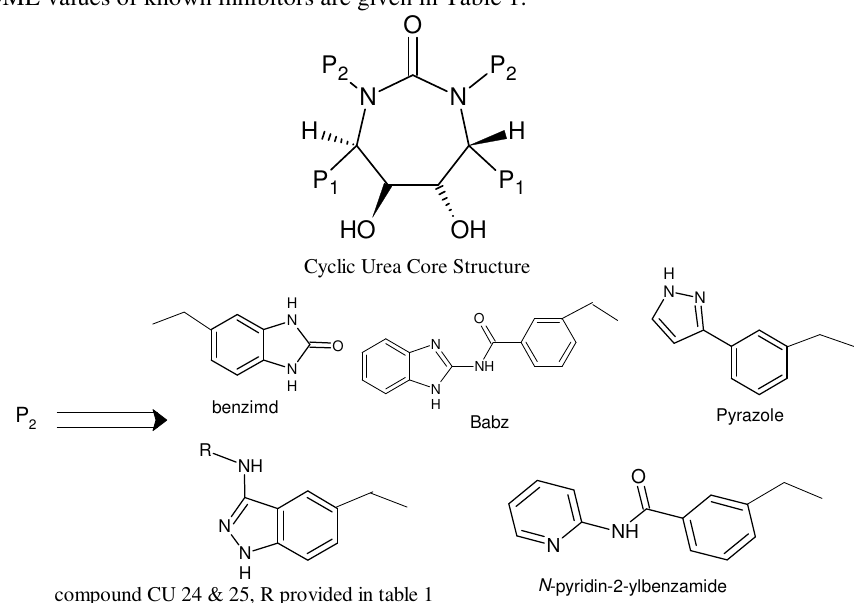
Figure 1. Structure of Cyclic urea inhibitors. P